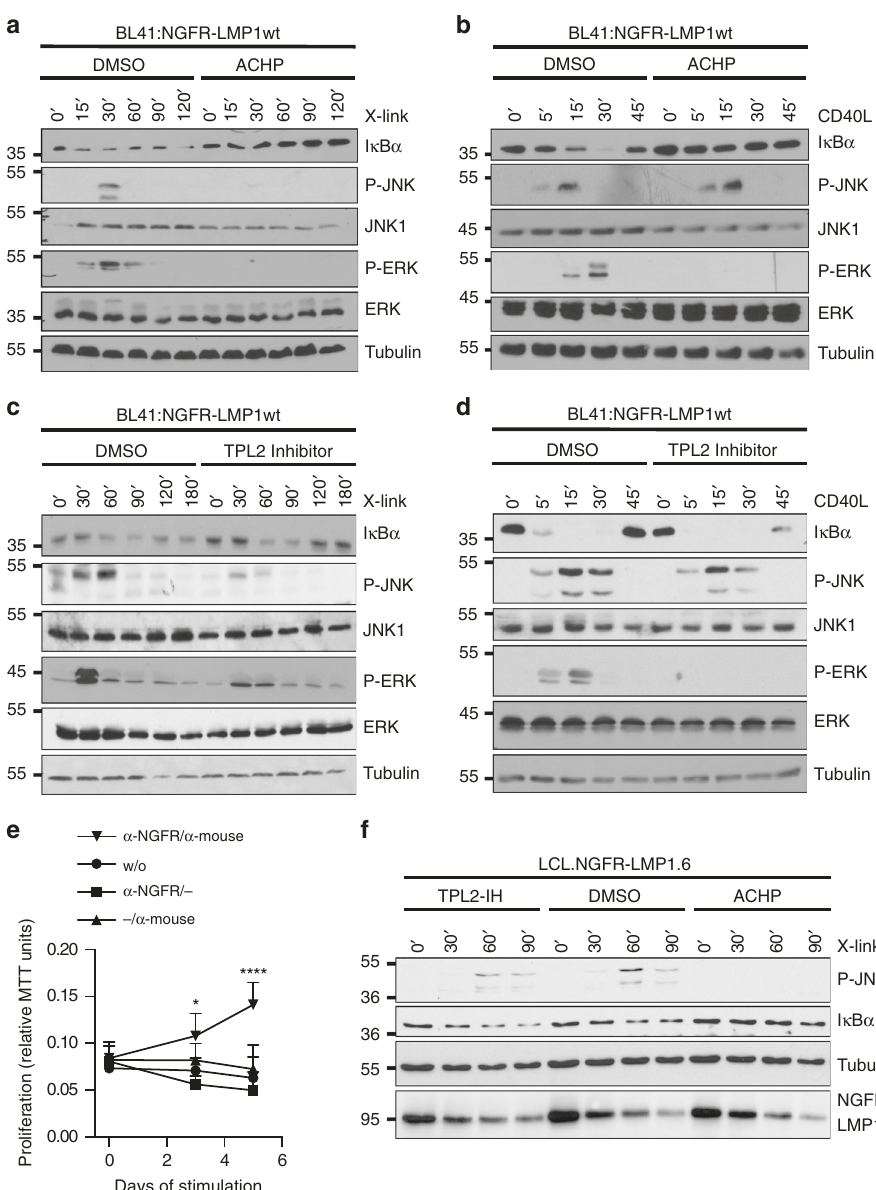
Fig. 6 LMP1 signaling to JNK differs from CD40 and requires IKK2 and TPL2 in B cells and LCLs. a , b Effects of IKK inhibition on JNK, ERK, and canonical NF- κ B signaling by LMP1 ( a ) and CD40 ( b ) in human B cells. BL41:NGFR-LMP1wt cells were treated with solvent (DMSO) or 5 µ M ACHP. a NGFR-LMP1 activity was induced by antibody crosslinking (X-link), b CD40 was activated with 600 ng/ml soluble CD40 ligand (CD40L) for the indicated times. JNK, ERK, and NF- κ B activation was detected in total cell lysates using the indicated antibodies. c , d Effects of TPL2 inhibition. Cells were treated with DMSO or 10 µ M TC-S7006 (TPL2-IH). e Proliferation of LCL.NGFR-LMP1.6 cells depends on LMP1 activity. LCLs were established by infection of primary human B cells with EBV expressing NGFR-LMP1 instead of wildtype LMP1. Cells were deprived of crosslinking antibodies for 7 days to fully silence the chimeric receptor. Subsequently, the cells were re-stimulated as indicated and proliferation was measured as MTT conversion. Primary antibody: α -NGFR, secondary antibody: α -mouse IgG/IgM. The data are mean values± SD of at least four biological replicates. f LMP1 signaling to JNK involves IKK2 and TPL2 in EBV-transformed human B-cells. LCL.NGFR-LMP1.6 cells were activated by antibody crosslinking in the presence of DMSO, ACHP, or TPL2-IH. JNK and canonical NF- κ B activity was analysed by immunoblotting. NGFR-LMP1 was detected with the LMP1 antibody 1G6-3. e Statistical analysis was performed with two-way ANOVA at alpha 0.05, p -values: *p ≤ 0.05, **** p ≤ 0.0001. a – d , f The data are representative of at least two independent experiments. For immunoblot quanti fi cation and statistics see Supplementary Table on IKK2 in these LCLs (Fig. 6f). Also I κ B degradation induced by NGFR-LMP1 was blocked by ACHP. TPL2 inhibition caused a marked decrease in JNK activation, whereas induction of canonical NF- κ B was not affected. IKK2 and TPL2 are, thus, mediators of JNK activation by LMP1 in EBV-transformed B cells, which depend on LMP1 signals.